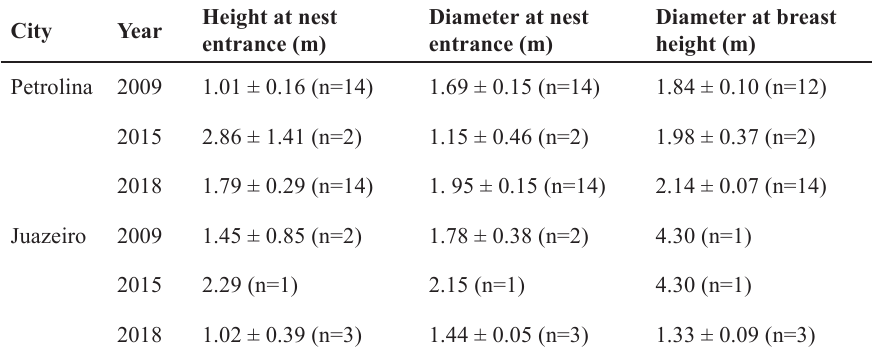
Table 2 . Means (and standard errors) of measures obtained for nests of Plebeia aff. flavocincta in Petrolina and Juazeiro, in 2009, 2015 and 2018. Legend: n: number of Diameter at nest Diameter at breast entrance (m) entrance (m)